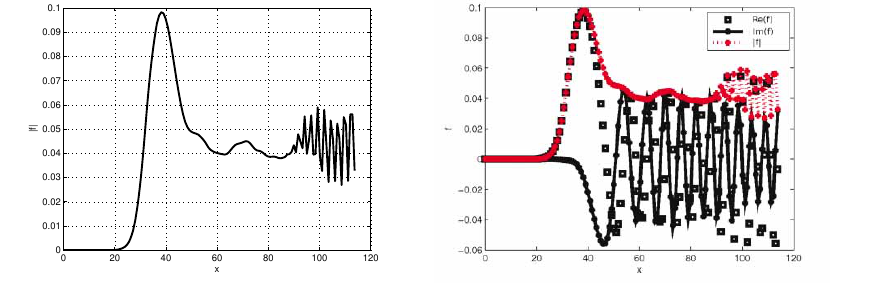
Figure 20. Finite difference scheme solutions for | f ( t f ,x ) | , t f = 10.